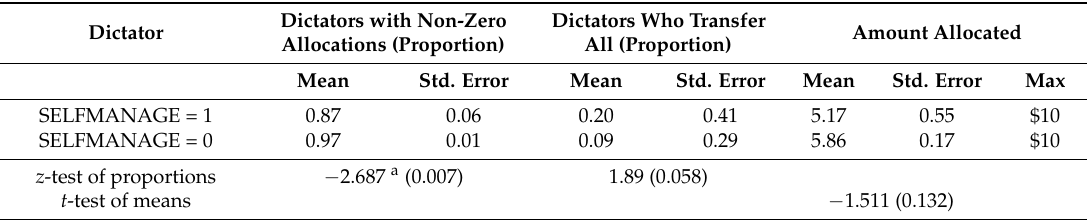
Table 7. Allocation of $10 based on SELFMANAGE.